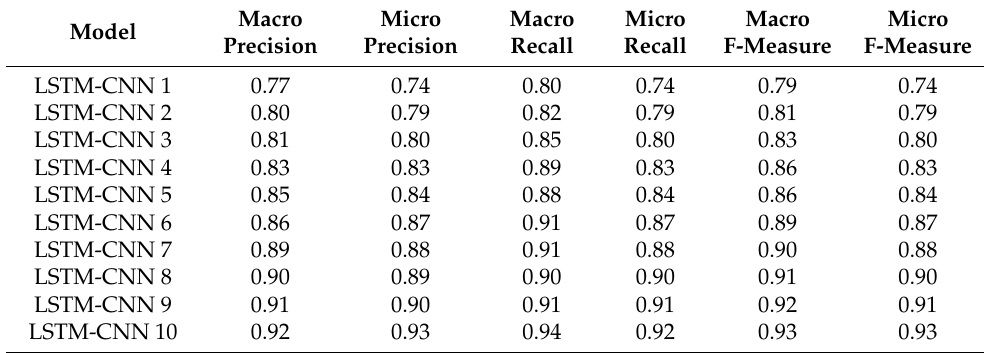
Table 6. Performance measures of LSTM+CNN court case prediction models.